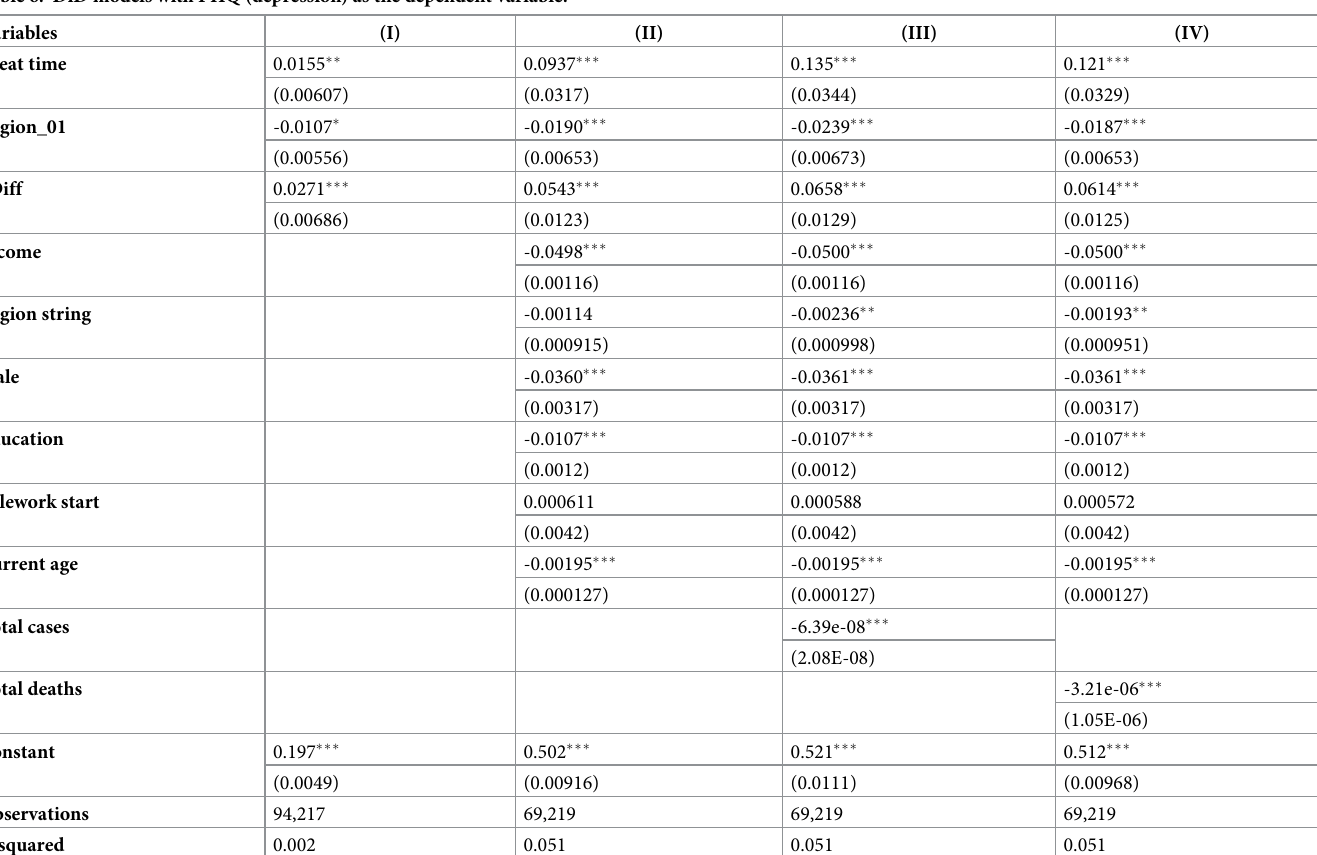
Table 6. DiD models with PHQ (depression) as the dependent